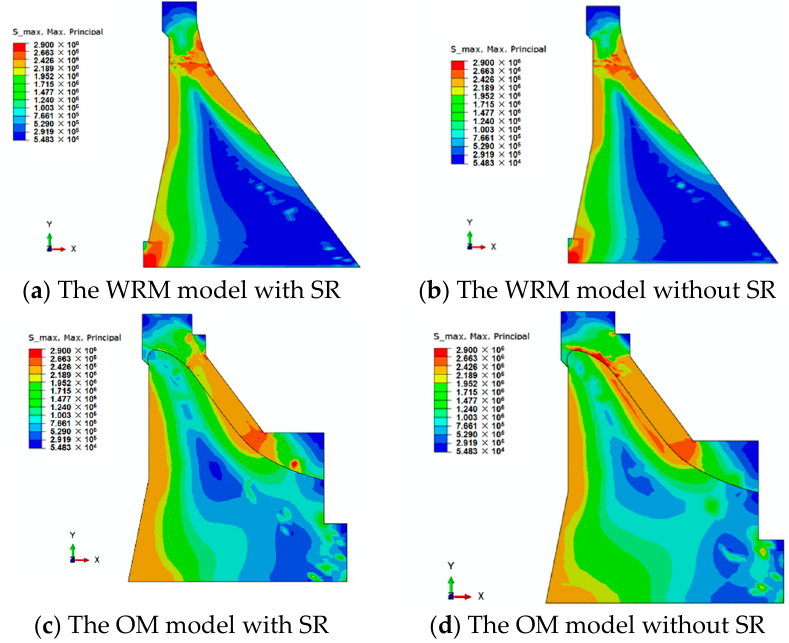
Figure 14. The maximum tensile stress in the concrete of Huangdeng dam.